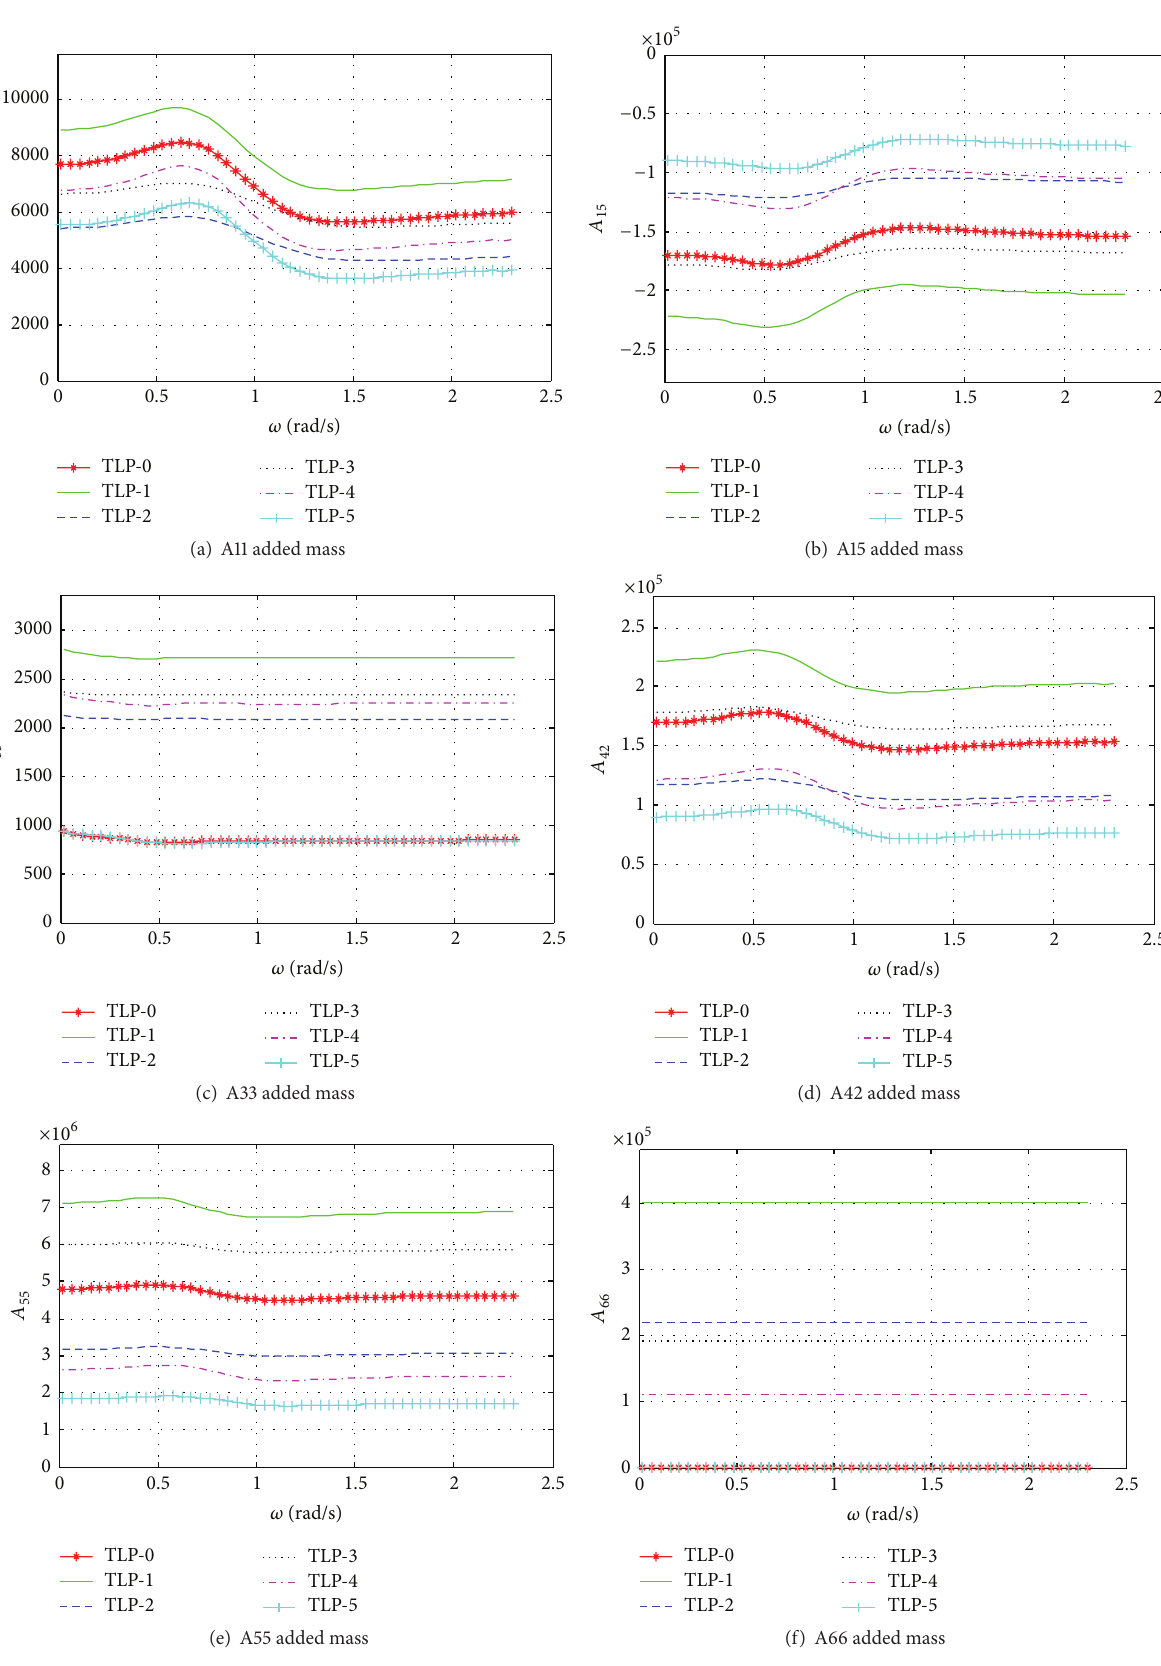
Figure 6: Added mass